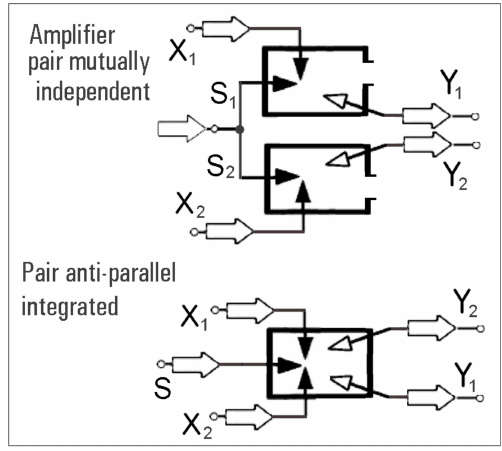
Figure 5. In generation of oscillatory flows it is often useful to have two amplifiers connected so that they form the anti-parallel pair. They are integrated (bottom) to form a single circuit